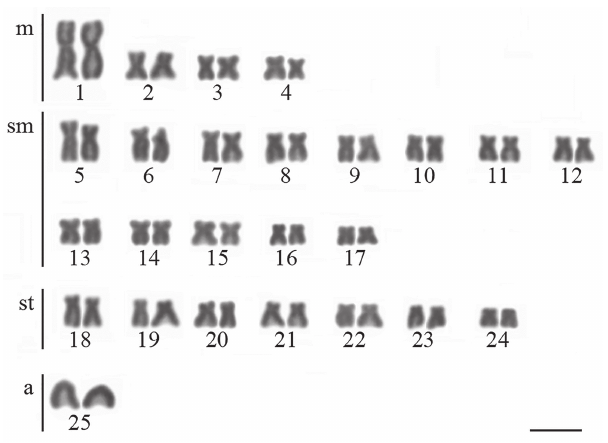
Fig. 2. Representative karyotype of Nematocharax venustus . Bar = 5 µm.